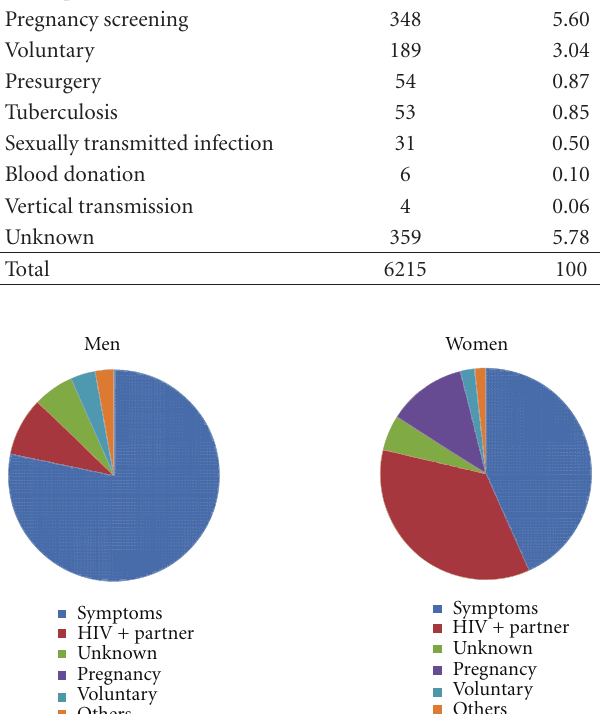
three di ff erent CD4 lymphocyte count thresholds for starting ART according to current guidelines [1–3,